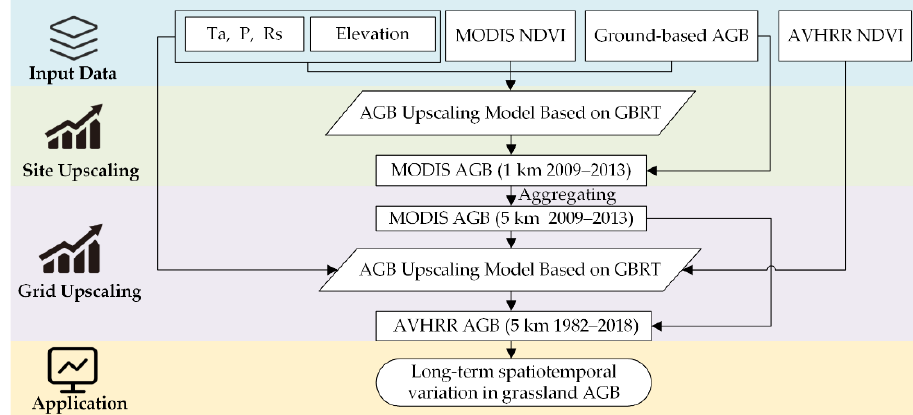
Figure 2. Flowchart to generate long-term (1982–2018) grassland AGB dataset in the